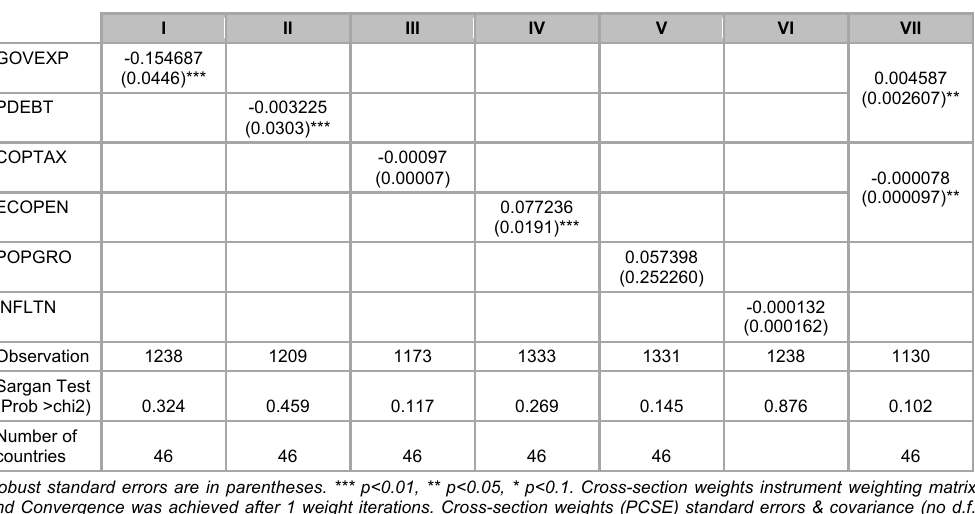
Determinants of FDI flow to Africa (Dependent Variable –